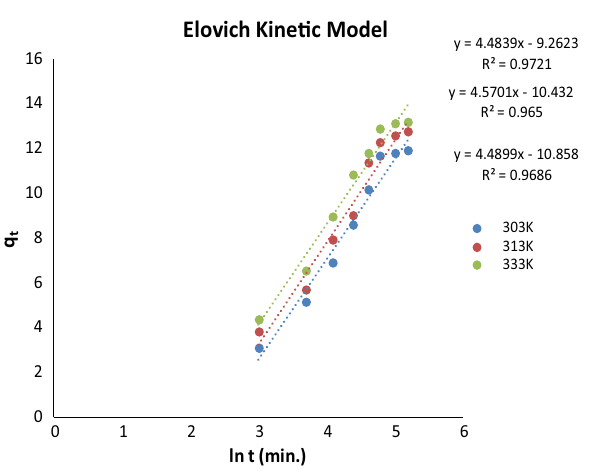
Fig. 20 Bhattacharya–Venkobachar model. Temperature—30,